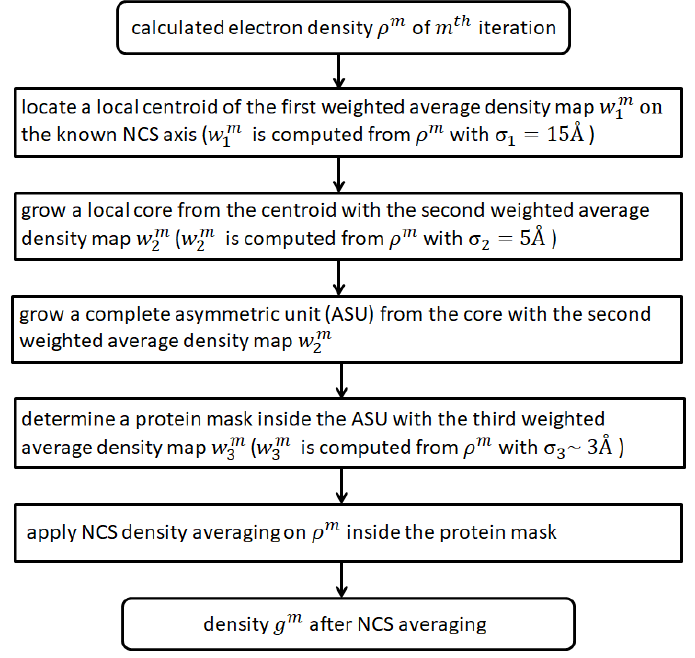
Figure 3. A flowchart for computing the NCS